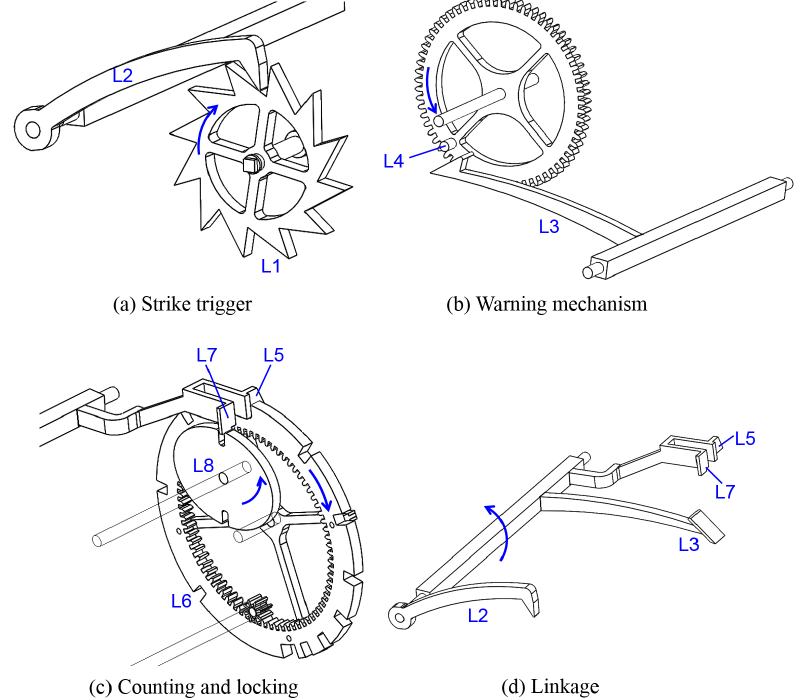
Figure 16. Structure and operation of the N5 striking trigger.